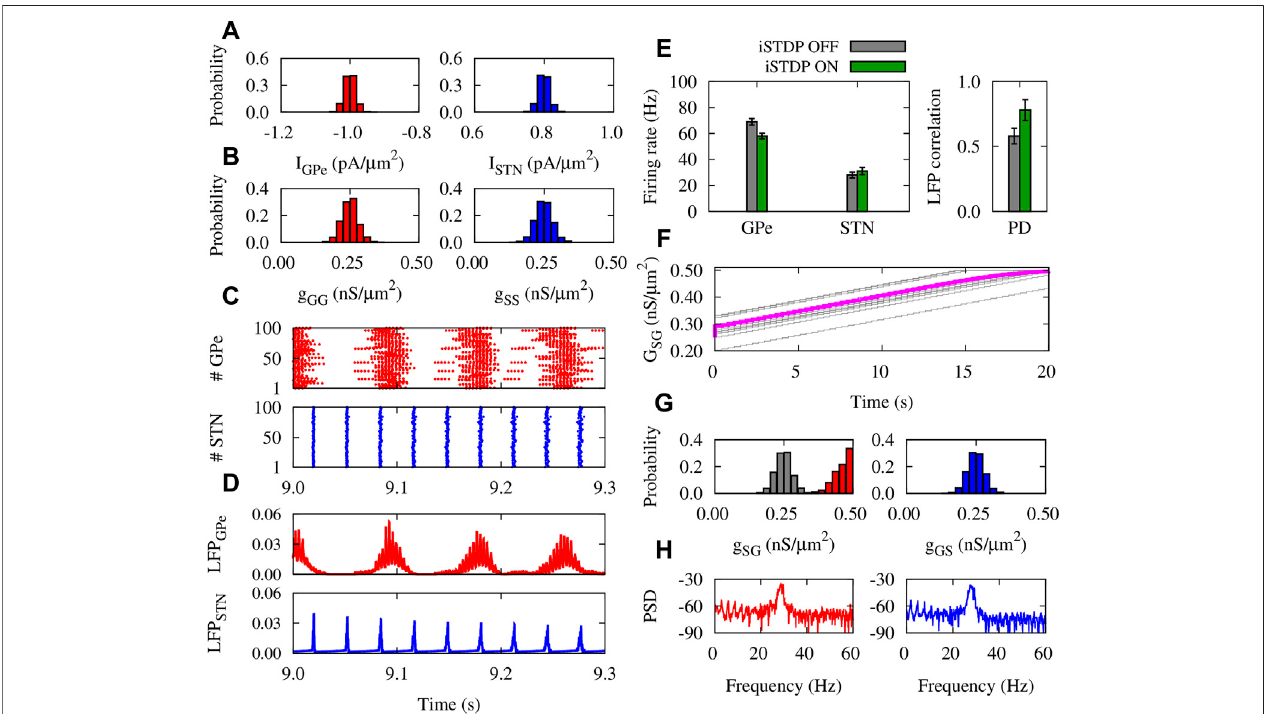
FIGURE5| PropertiesoftheGPe-STNnetworkmediatedbyiSTDPinPDcondition. (A) Normal distribution ofcurrentsapplied toGPe(left)andSTN (right)around I GPe = − 1.0 pA/ μ m 2 and I STN = 0.8 pA/ μ m 2 . (B) Normal distribution of GPe-GPe (left) and STN-STN (right) synaptic strengths around 0.25 nS/ μ m 2 . (C) Raster plots of GPe (top) and STN (bottom). (D) LFP of GPe (top) and STN (bottom). (E) Mean fi ring rate of GPe and STN neurons (left) and the correlation between the GPe and STN LFPs (right). (F) Timecourse ofthemeanGPe-STN coupling (magenta) andten randomly chosen individualsynapticstrengths(grey). (G) Normal distribution ofthe initial GPe-STN (left; grey) and STN-GPe (right) synaptic strengths. Final distribution of the GPe-STN synaptic strengths is depicted in red (left). (H) PSD of the GPe (left) and STN (right)